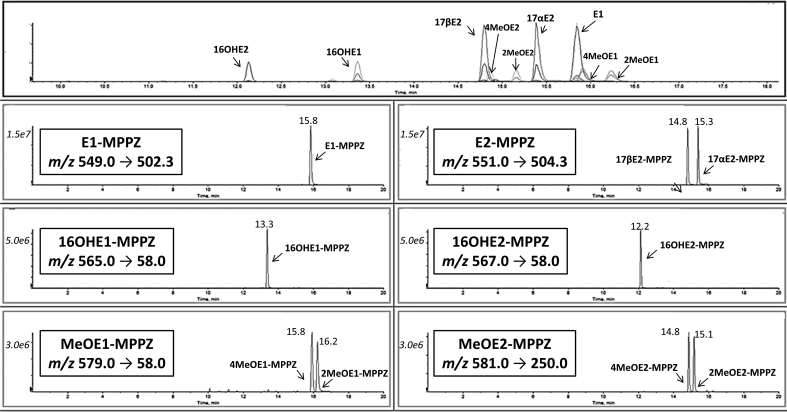
Mass chromatograms of methylpiperazine (MPPZ) derivatives of estrogens and their metabolites following analysis of an extracted solution of Standards, 2000 pg mL-1. Total Ion Chromatograms and the corresponding extracted ion chromatograms showing resolution of derivatives of estrone (El), estradiol (17α & 17βE2), 16- hydroxyestrogens (16OHE1 & 16OHE2) and methoxyestrogens (2MeOEl, 4MeOEl, 2MeOE2 & 4MeOE2) by retention time and mass transition.